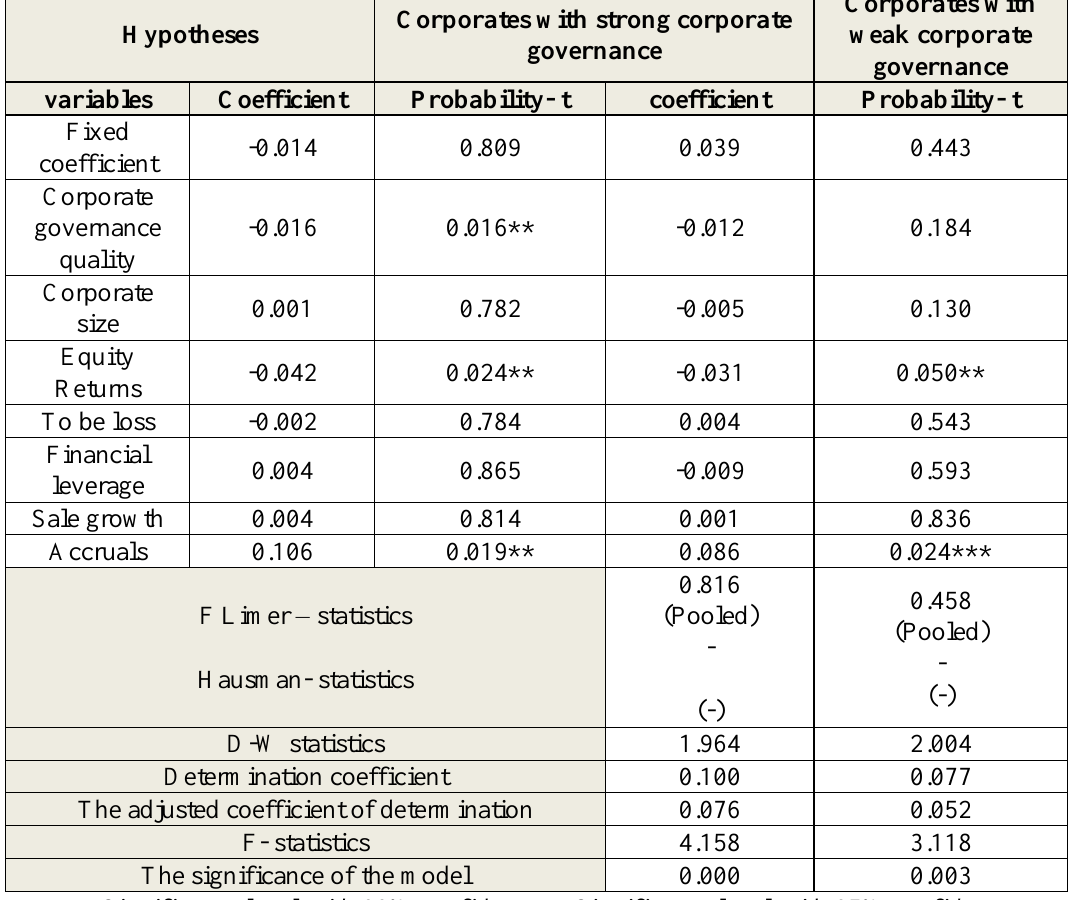
Table 7: Test results of the fourth